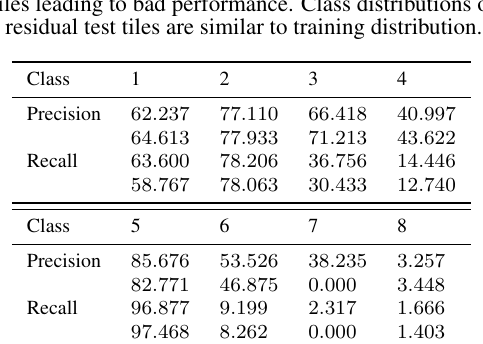
Table 3. Per-class precision and recall (in % ) for predictions of the 1D CNN ( top row ) and RF ( bottom row ) for Tile A with best performing feature configuration (all geometric features but only Median HSV per face and Hue Hist Level 0 per SPNH as textural features). Class definitions are according to Figure